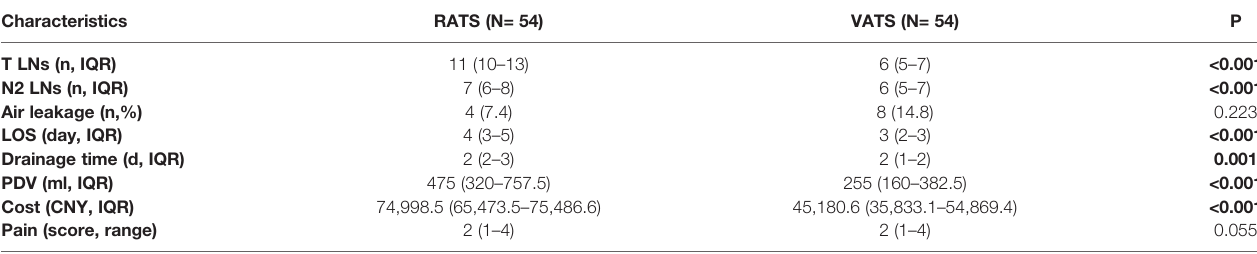
TABLE 3 | Postoperative outcomes of the propensity score – matched groups (N =108).